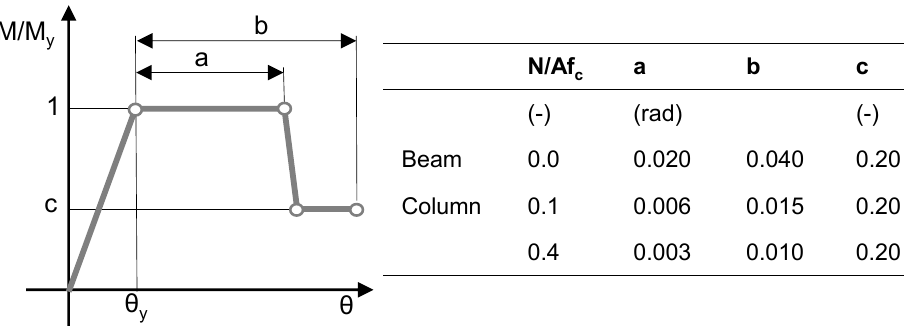
Figure 10. Definition of plastic hinges according to FEMA356 [40].